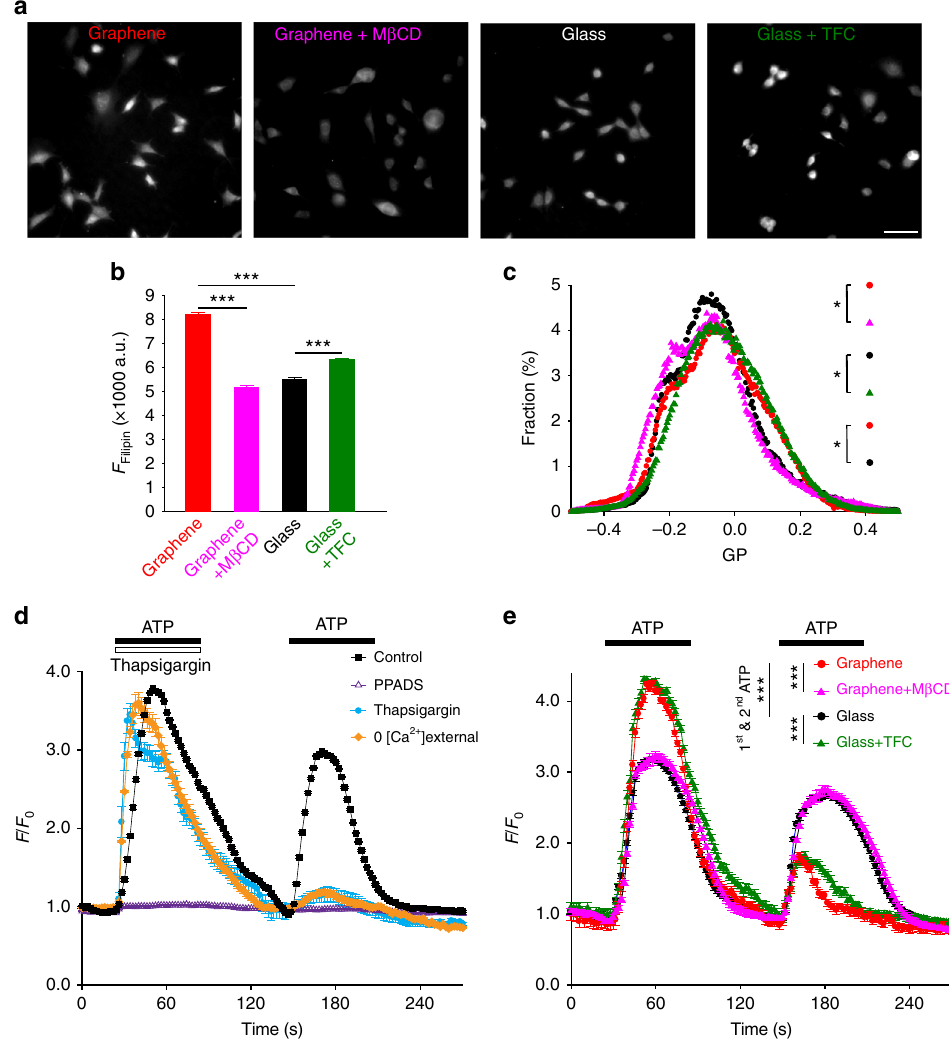
Fig. 9 Graphene enhances P2Y receptor-mediated Ca 2 + responses. a Sample images of Filipin staining of 3T3 cells on graphene with (purple) or without (red) M β CD treatment and on glass with (green) or without (black) TFC loading. Same color coding hereafter. Scale bar, 50 μ m. b Average intensities of Filipin staining ( n graphene = 1536 cells, n graphene + MBCD = 2286 cells, n glass = 1317 cells, n glass + TFC = 1487 cells, N = 3 batches for every group; for graphene vs. graphene + M β CD, graphene vs. glass, and glass vs. glass + TFC, *** p < 0.001, all Wilcoxin rank-sum tests). c Distributions of GP values over individual image pixels ( n = 6 FOVs, N = 3 batches; for graphene vs. graphene + M β CD graphene vs. glass, glass vs. glass + TFC, all * p < 0.05, for graphene vs. glass + TFC, p > 0.05, Kolmogorov – Smirnov test of the distributions of GP values, see 'Statistical analysis' in the Methods section). d Two consecutive 100- µ M ATP applications elicited the release of Ca 2 + from internal Ca 2 + stores ( n = 6 FOVs, N = 3 batches for every condition). The second Ca 2 + response was smaller than the fi rst with a 1 min interval between. Both Ca 2 + responses were blocked by 50 μ M PPADS (pyridoxalphosphate-6-azophenyl-2 ’ ,4 ’ - disulphonic acid), a P2YR inhibitor (white triangles). Thapsigargin 1 μ M (blue dots) elicited a similar Ca 2 + response as ATP but signi fi cantly reduced the second response by exhausting internal Ca 2 + stores. In the absence of extracellular Ca 2 + (the source for re fi lling internal Ca 2 + stores) (orange diamonds), the second response was also signi fi cantly reduced ( n = 6 FOVs, N = 3 batches for every condition). e ATP-elicited Ca 2 + release from internal stores was facilitated by graphene or TFC pretreatment and reduced by M β CD ( n = 6 FOVs, N = 3 batches for every group; for graphene vs. graphene + M β CD, graphene vs. glass, and glass vs. glass + TFC, *** p < 0.001, two-tailed t -tests). Error bars are